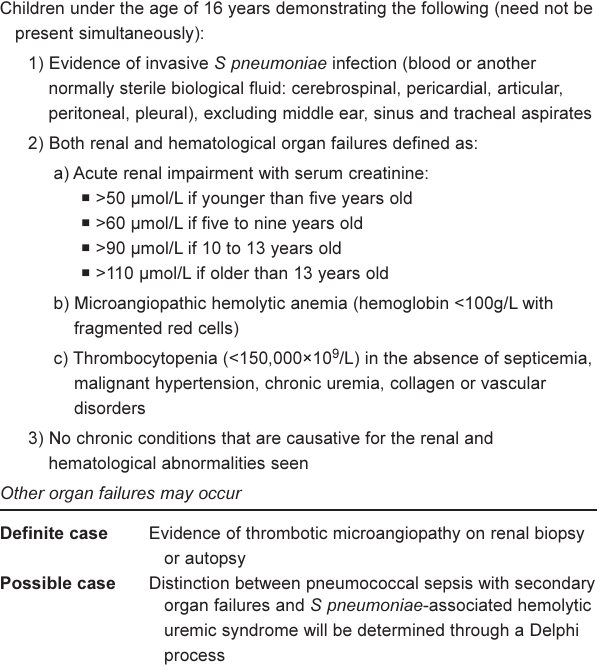
TABLE 1 Canadian Paediatric Society Streptococcus pneumoniae - associated hemolytic uremic syndrome case definitions Children under the age of 16 years demonstrating the following (need not be present